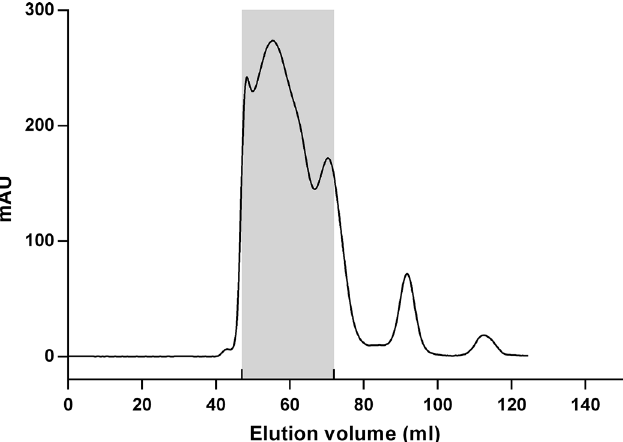
Fig 2. Absorbance profile (280 nm) of fractionation of Pfs25M-EPA across a 16 mm X 60 mm column pack with Superdex 200 matrix. The shaded area represents the fractions that were pooled.